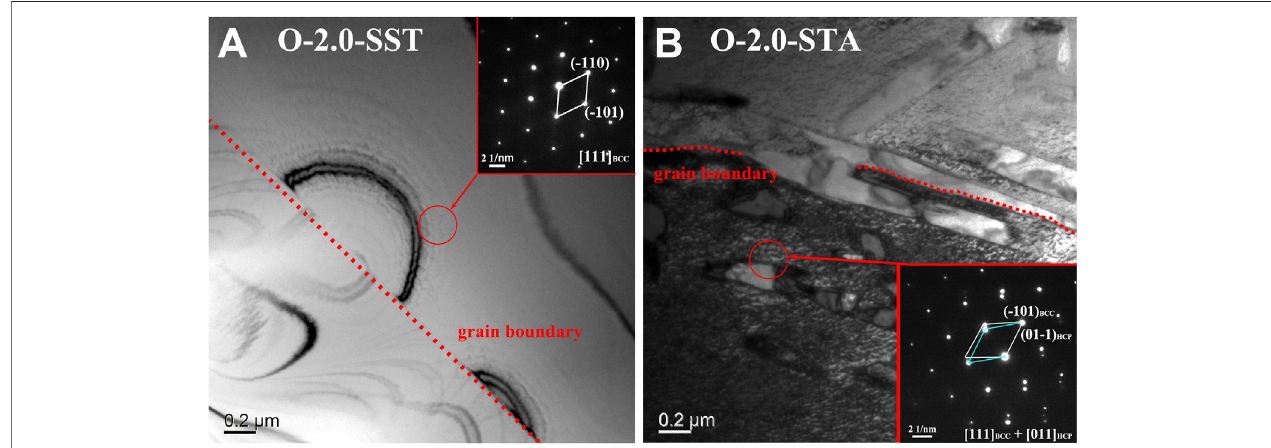
FIGURE 2 | Bright- fi eld TEM images of (A) O-2.0-SST and (B) O-2.0-STA. The insets are selected area electron diffraction (SAED) patterns corresponding to the areas marked by red